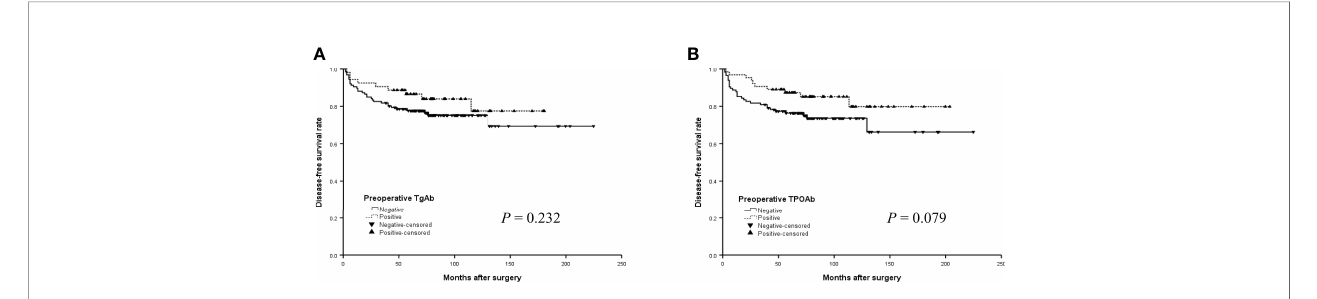
FIGURE 4 | The disease-free survival (DFS) curves of the positive or negative preoperative TgAb (A) and TPOAb (B) in all patients with